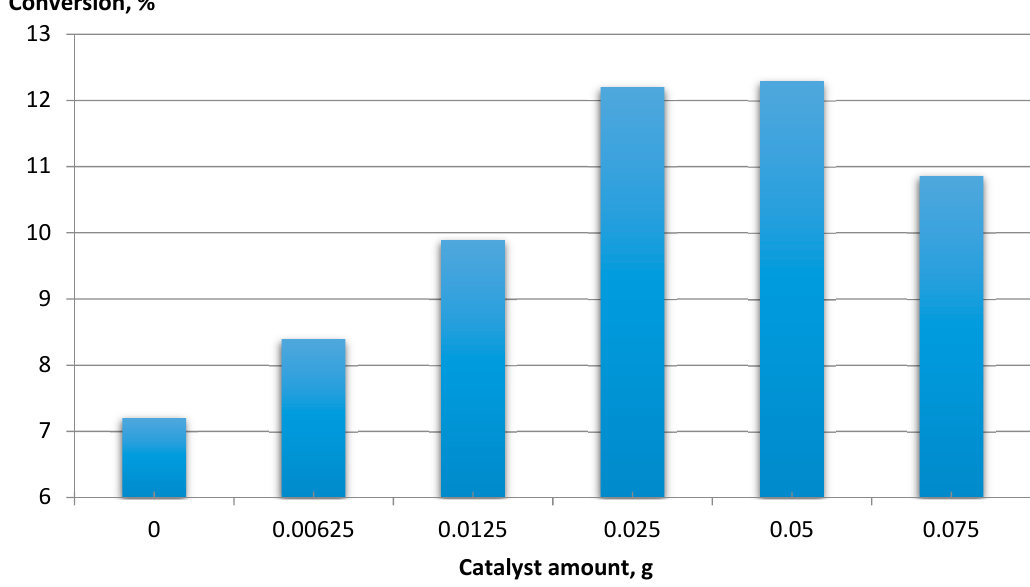
Figure 5. The dependence of EB conversion vs. the amount of catalyst. Ethylbenzene 16 mmol, NHPI 0.5 mol%, AIBN 0.2 mol%, 80 °C, 6 h, 1200 rpm, MWCNT-COO-Co.